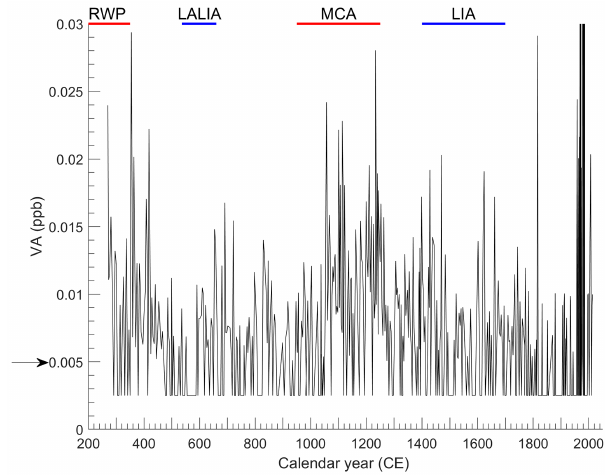
Figure 2. Tunu ice core VA record. The horizontal lines show the Roman Warm Period (RWP), Late Antique Little Ice Age (LALIA), Medieval Climate Anomaly (MCA), and the Little Ice Age (LIA) (Büntgen et al., 2016; Mann et al., 2009; Wang et al., 2012). The arrow indicates the limit of detection. All data below the limit of detection are treated as half of the limit of detection. Six measure- ments above 0.03ppb not shown in this figure are shown in Fig.